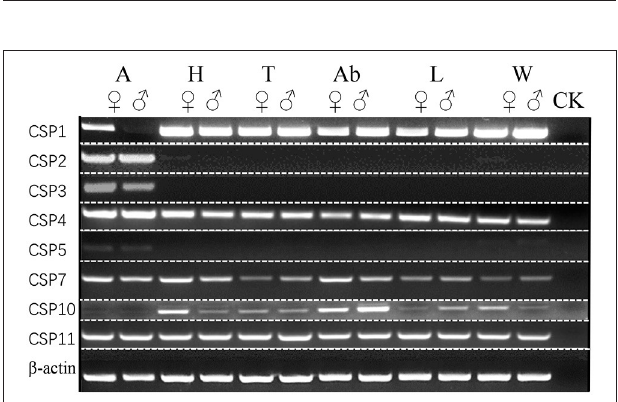
FIGURE 8 | Sex- and tissue-specific expression of candidate ScosCSPs. A, antennae; H, head; T, thorax; Ab, abdomen; L, leg; W, wing; ck, control [ultra-pure water